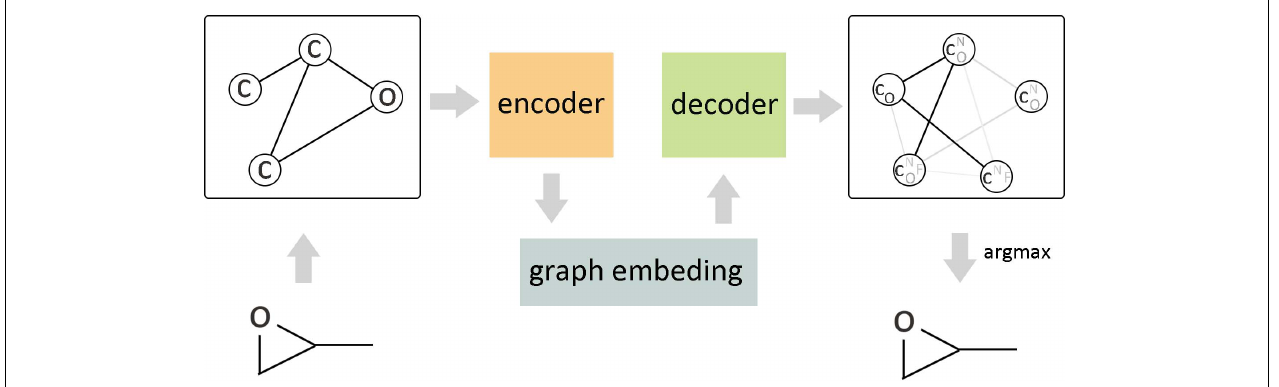
FIGURE 8 | Variational graph autoencoder (VGAE) in molecular graph generation. As the encoder of VGAE, the edge condition convolution embedded the original graph into a continuous vector space, and the decoder generated a probabilistic fully connected graph according to the predefined number of nodes and updated the parameters through approximate graph matching to improve the reconstruction ability of the